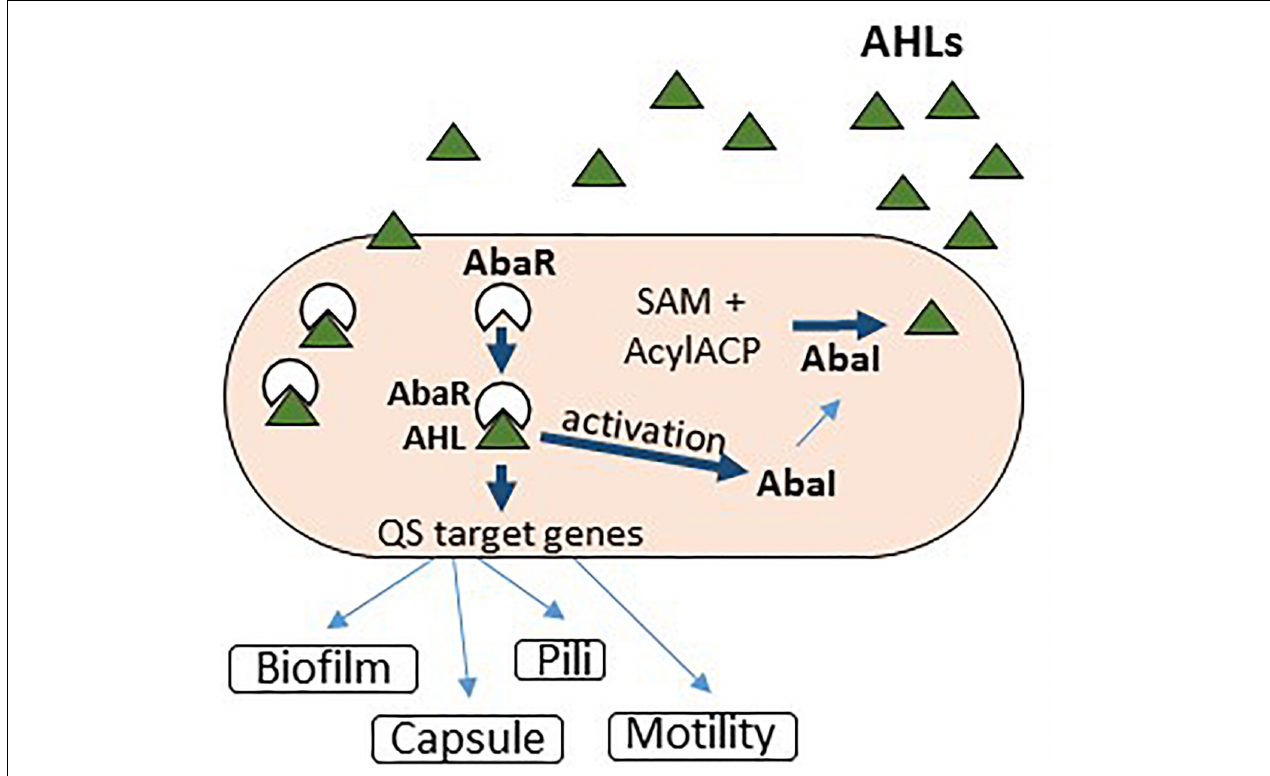
FIGURE 1 | Quorum sensing signaling in Acinetobacter